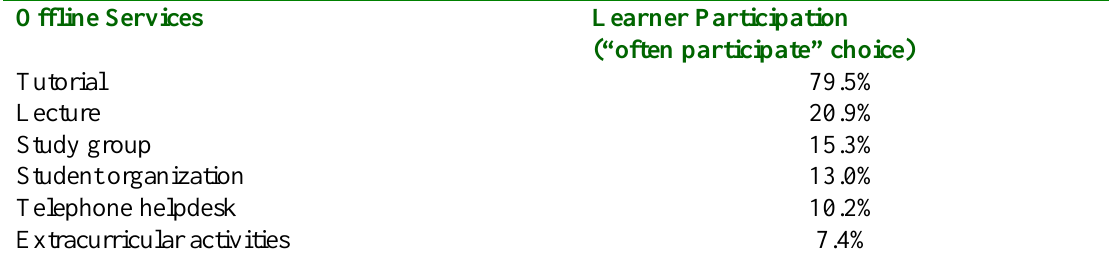
Table 7. Learners’ ratings of offline learner support services